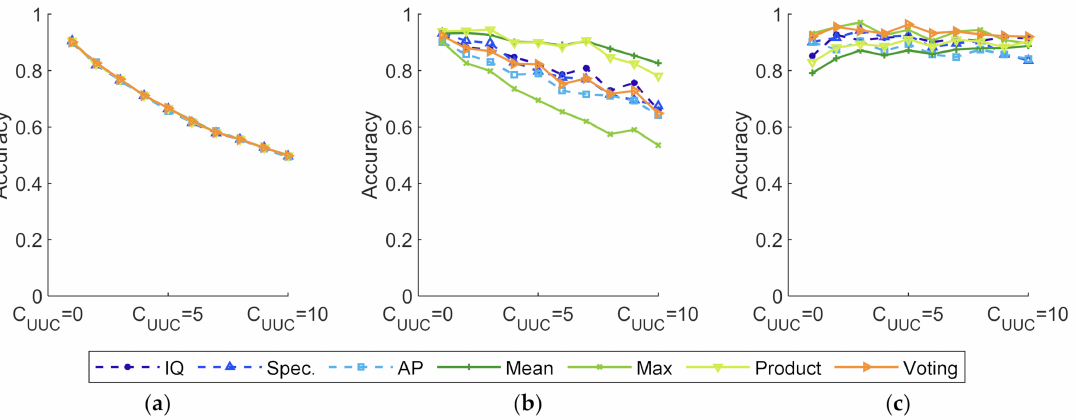
Figure 12. Accuracy of experiments with various C UUC and classifiers. ( a ) Softmax as basic classifiers; ( b ) softmax-threshold as basic classifiers; ( c ) OpenMax as basic